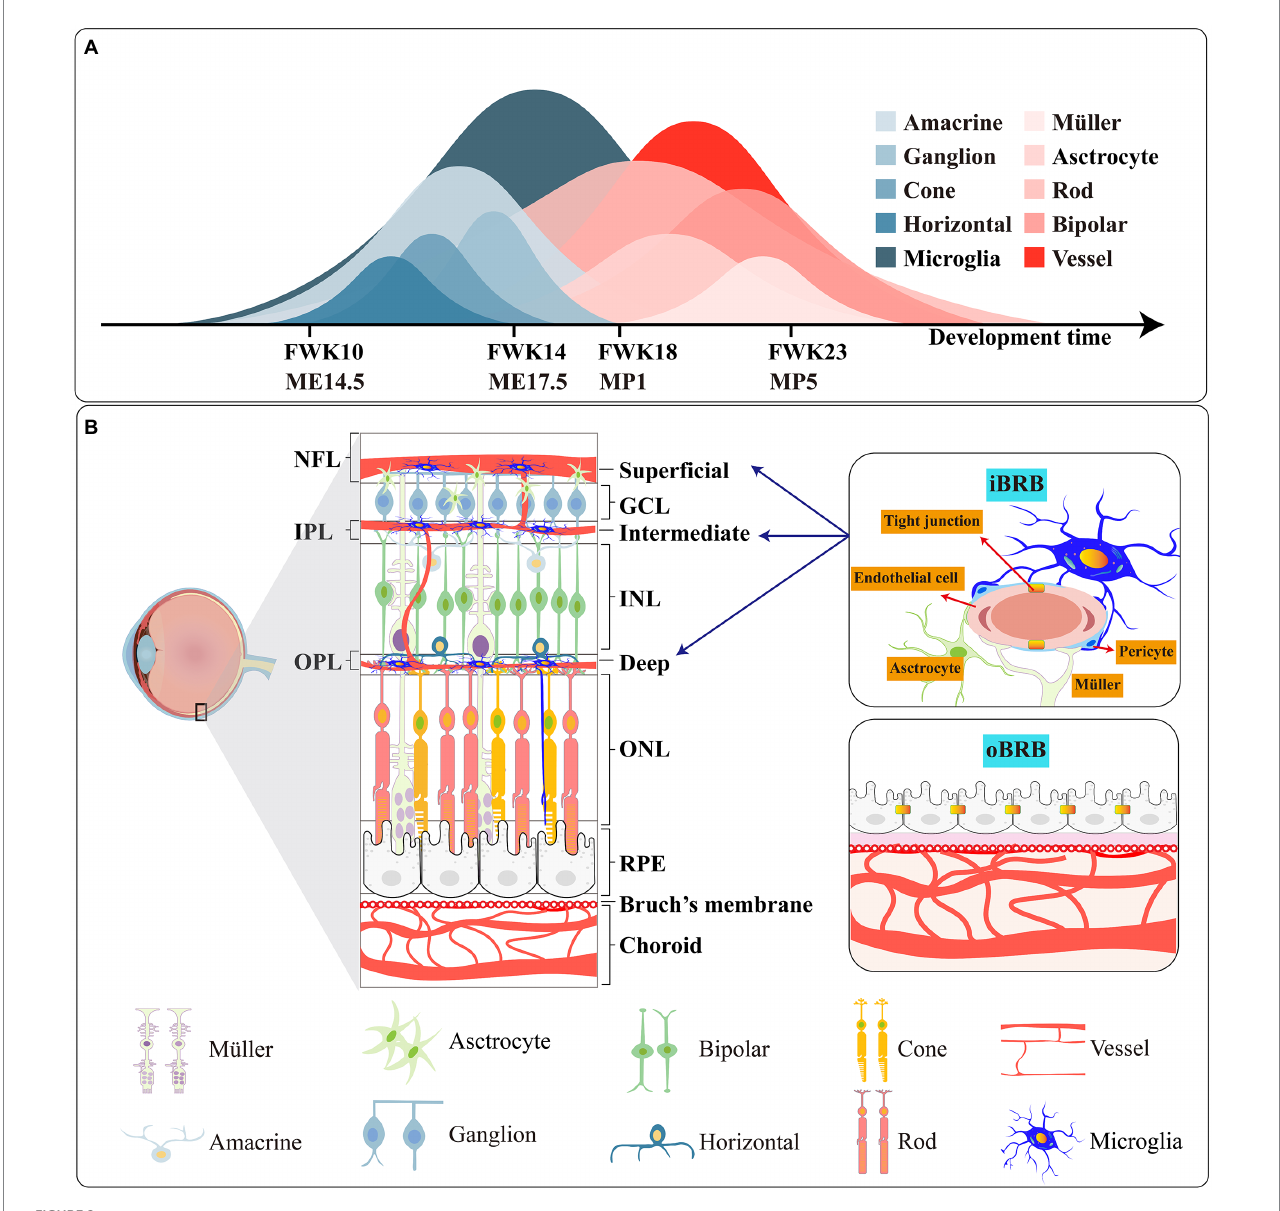
FIGURE 2 (A) Genesis of retinal cells during the development of the human and mouse. FWK-fetal week; ME-mouse embryo; MP-mouse postnatally. (B) Schematic picture of the retina, the iBRB and oBRB. The main types of tight junction protiens are different in iBRB and